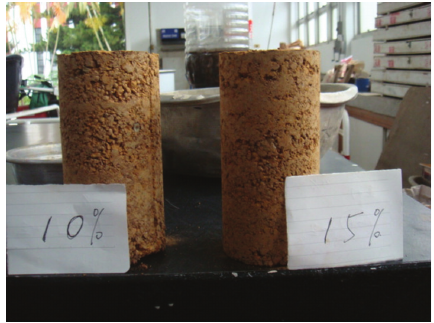
Figure 3: Compacted soil